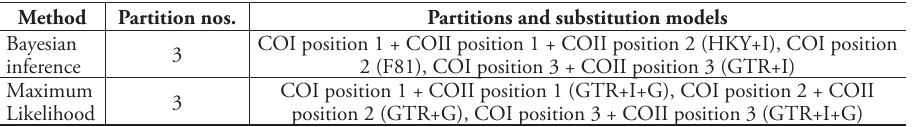
Table 1. Partitions and substitution models used in this study. Substitution models for ML method were reduced to